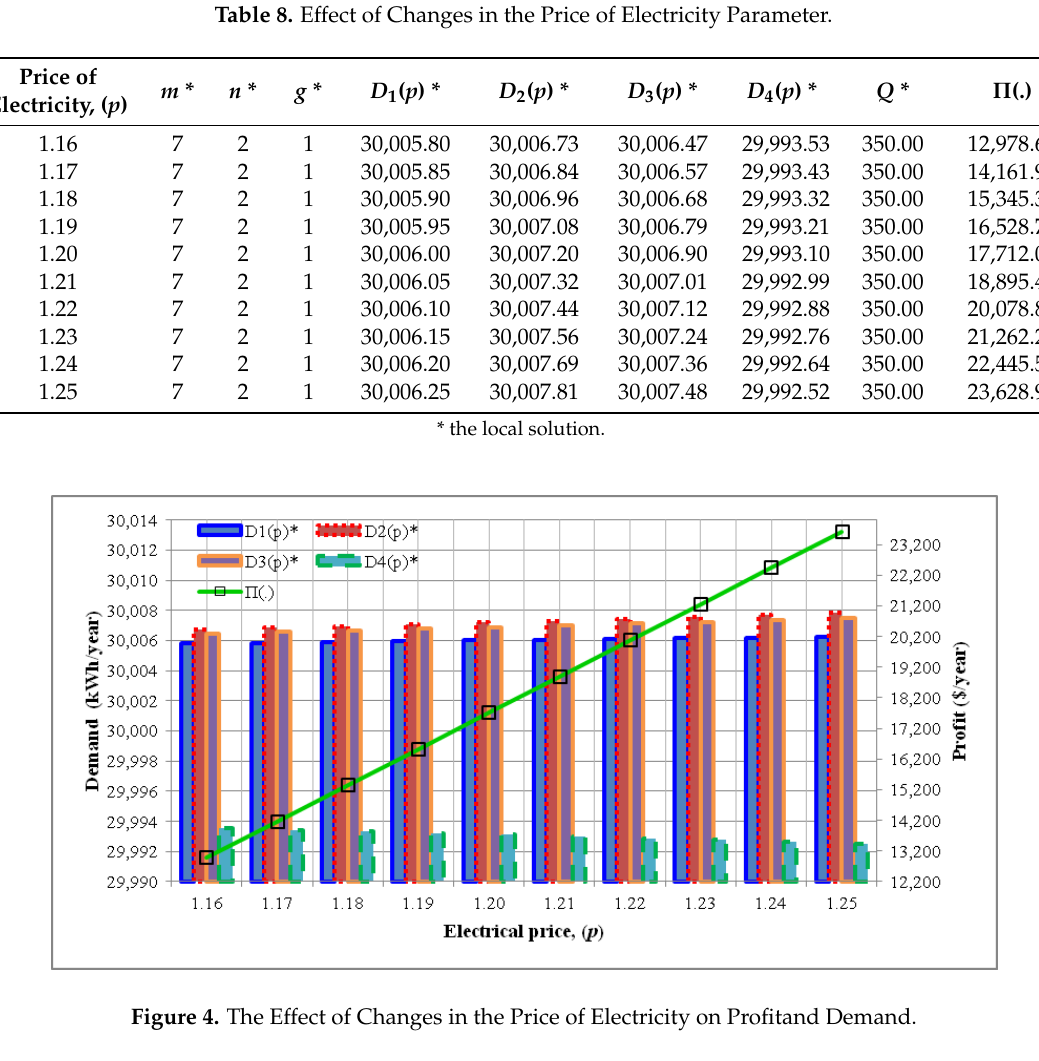
Table 9. Effect of Changes in the Production Cost Parameter.